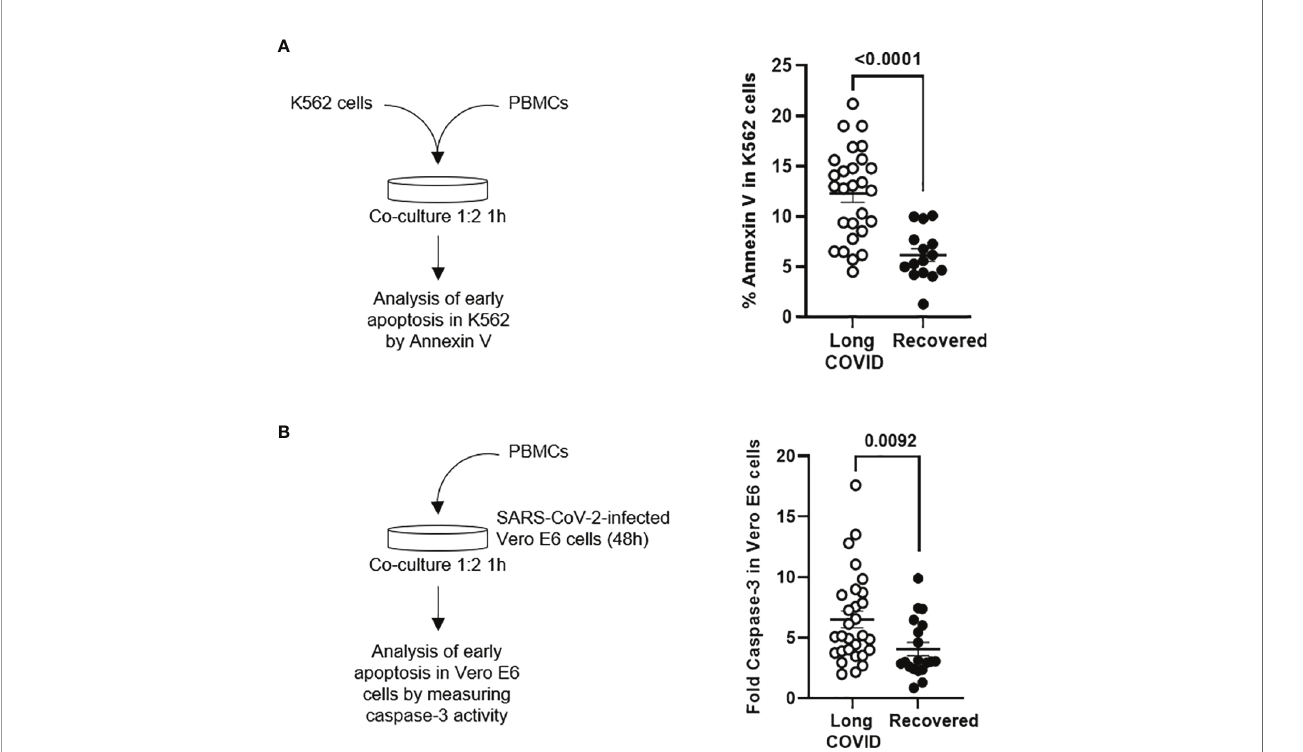
FIGURE 5 | Measurement of cytotoxic activity of PBMCs from the Long-COVID and Recovered groups. (A) Diagram (left) and dot plot graph (right) of the assay for the quanti fi cation by fl ow cytometry of Annexin V binding to K562 cells cocultured with PBMCs (1:2) from the Long-COVID and Recovered groups for 1 h (B) Diagram (left) and dot plot graph (right) of the assay for the quanti fi cation by chemiluminescence of caspase-3 activation in a monolayer of SARS-CoV-2-infected Vero E6 cells cocultured with PBMCs (1:2) from the Long-COVID and Recovered groups for 1 h Each dot in the graphs corresponds to one sample, and lines represent mean ± SEM. Statistical signi fi cance was calculated using non-parametric Mann – Whitney test. PBMCs, peripheral blood mononuclear